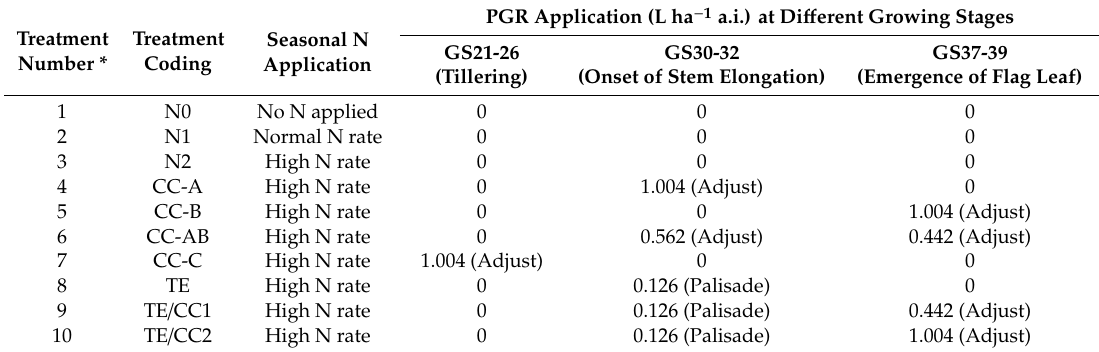
Table 2. Treatment details for the two-year field trials at Hermiston,